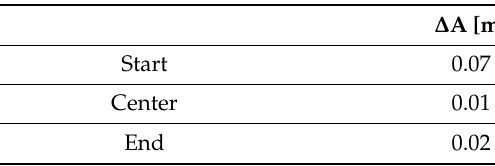
Figure 6. Center section measurements (red: TLS cloud; black: SfM cloud). Table 6. SfM/TLS comparison